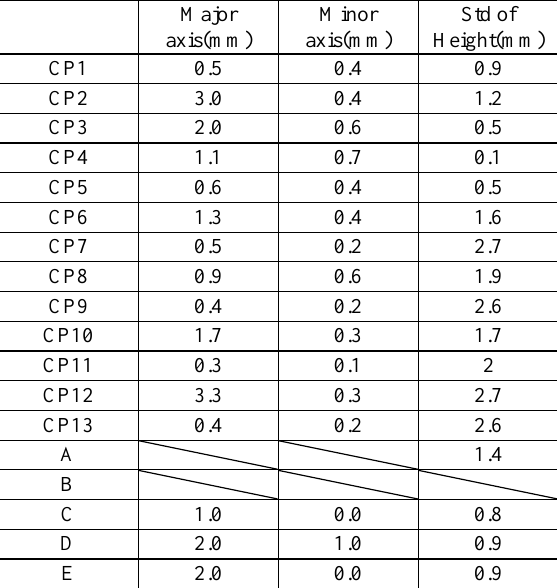
Table 1. The precision of the control